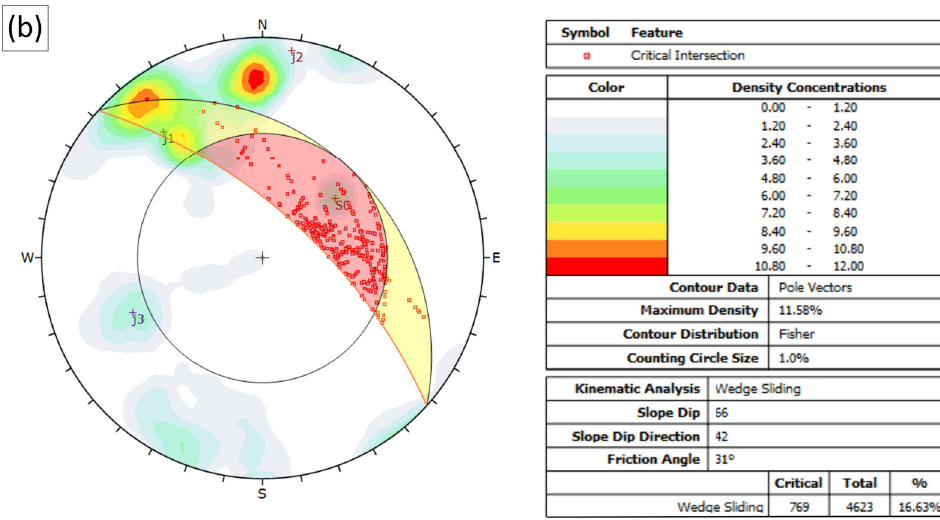
Figure 7. Kinematic analysis of slope stability. ( a ) Planar sliding failure; ( b ) wedge sliding.